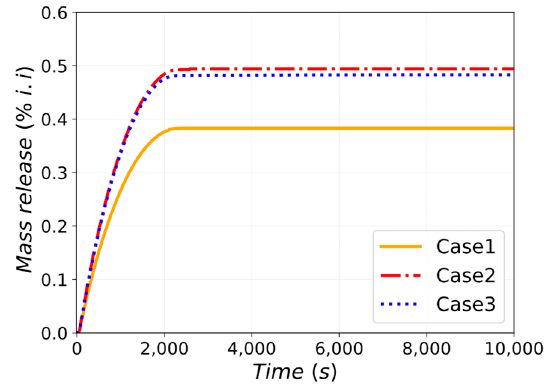
Figure 16. Direct unfiltered release of HTO (%i.i).